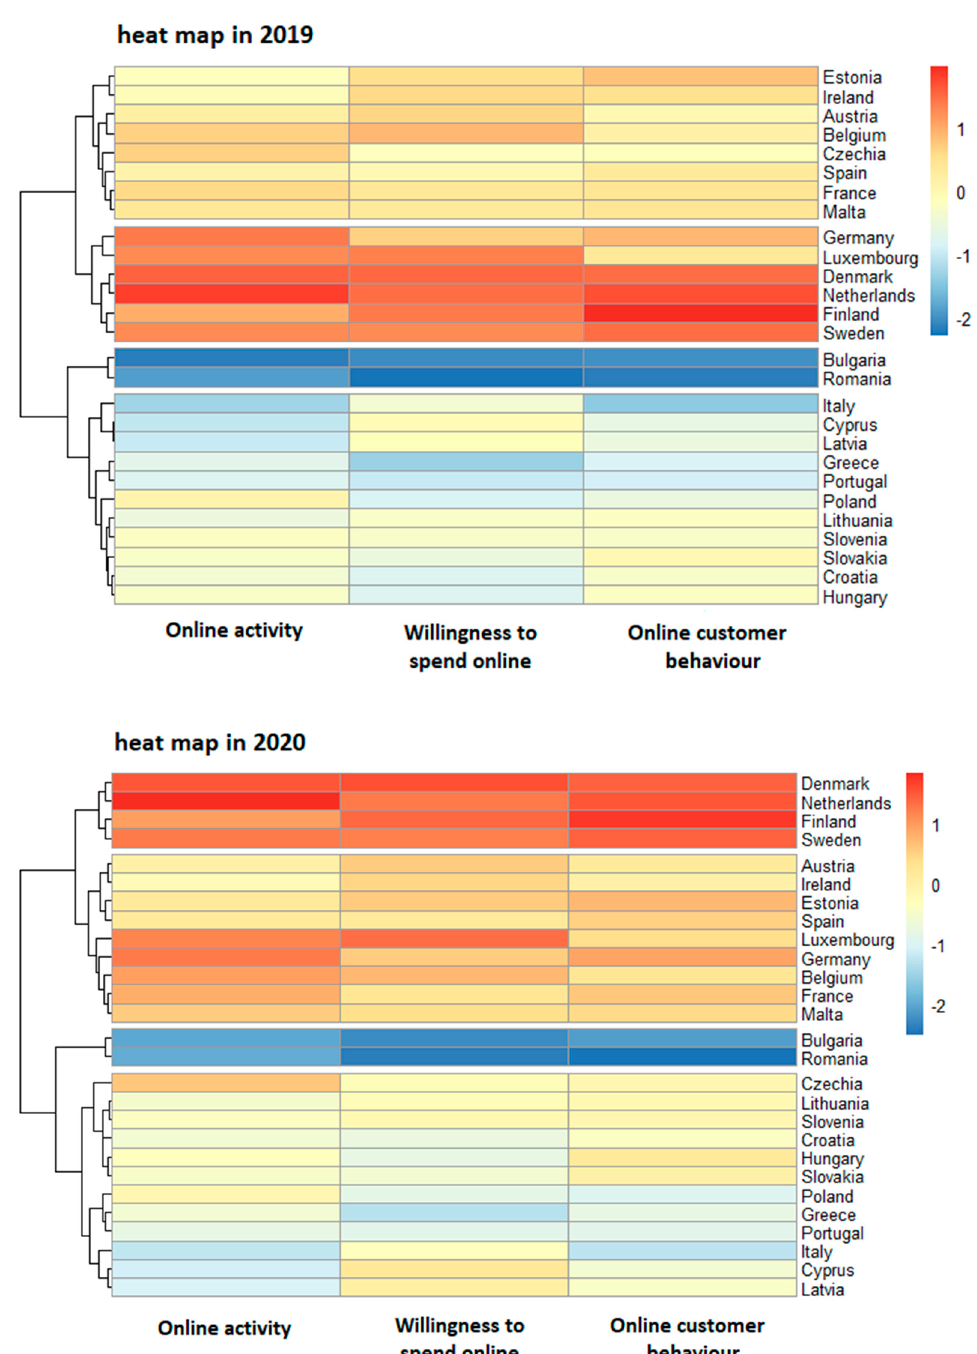
Figure 2. Clusters of EU countries performed for latent variables (colors indicate values of synthetic measures). Source, own study.